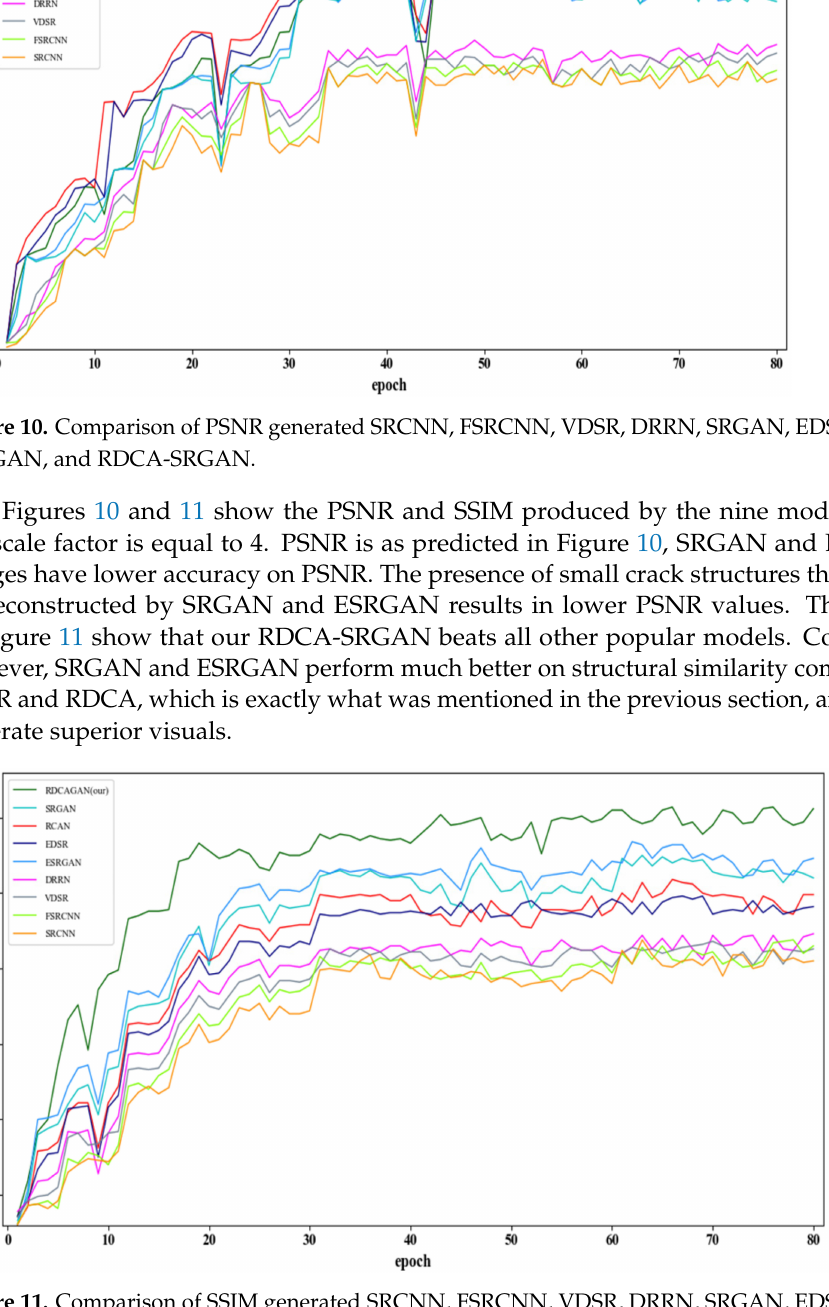
Figure 11. Comparison of SSIM generated SRCNN, FSRCNN, VDSR, DRRN, SRGAN, EDSR, RCAN, ESRGAN, and